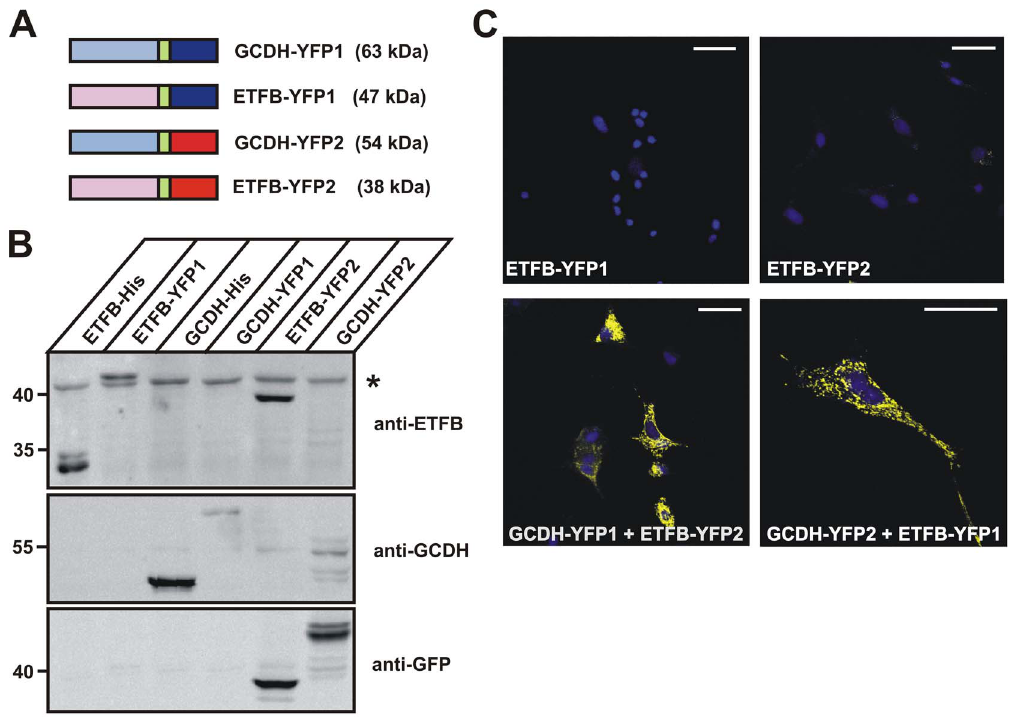
Figure 6. Interaction of GCDH with ETFB invivo . ( A ) Schematic representation of GCDH and ETFB fusion proteins with YFP1 (dark blue) and YFP2 (red). The 10-amino acid linker (GGGGS) 2 is indicated in green. The calculated molecular masses of the respective fusions proteins are shown in brackets. ( B ) The expression of the various fusion proteins used in this study were analyzed by western blotting. The 43 kDa band (*) reactive with the anti-ETFB antibody is unspecific. ( C ) Fluorescence microscopy of fixed BHK cells co-expressing GCDH and ETFB fusion proteins showed a strong YFP fluorescence. Nuclei were visualized using DAPI (blue). Scale bars=40 m M. Representative images of n=3 independent transfection experiments are